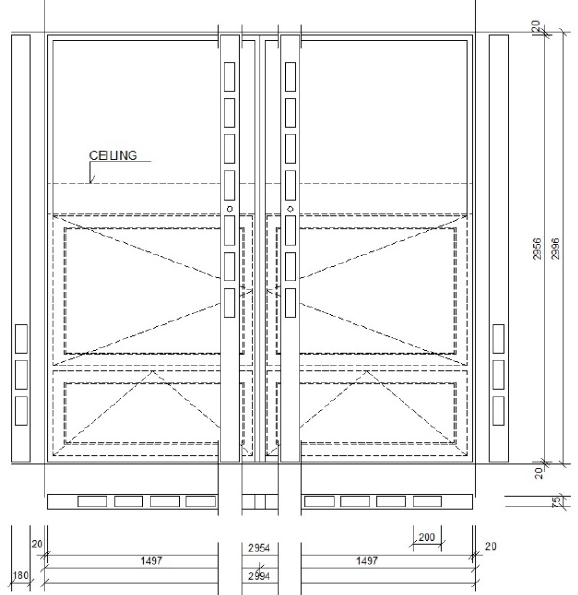
Figure 14: Construction diagram of the double skin facade element with a narrow type